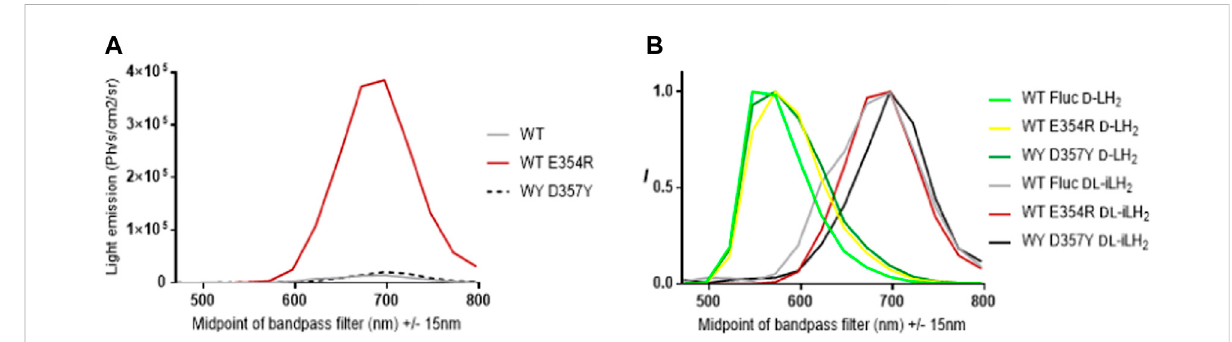
FIGURE 4 Effect of Fluc mutations E354R and D357Y on activity and color with DL -iLH 2 . (A) Quantitative bioluminescence spectra showing that E354R leadstosigni fi cantimprovementinactivitywith DL -iLH 2 . (B) NormalizedbioluminescencespectraofWT Ppy Fluc,E354R,andD357Ywith D -LH 2 and DL -iLH 2